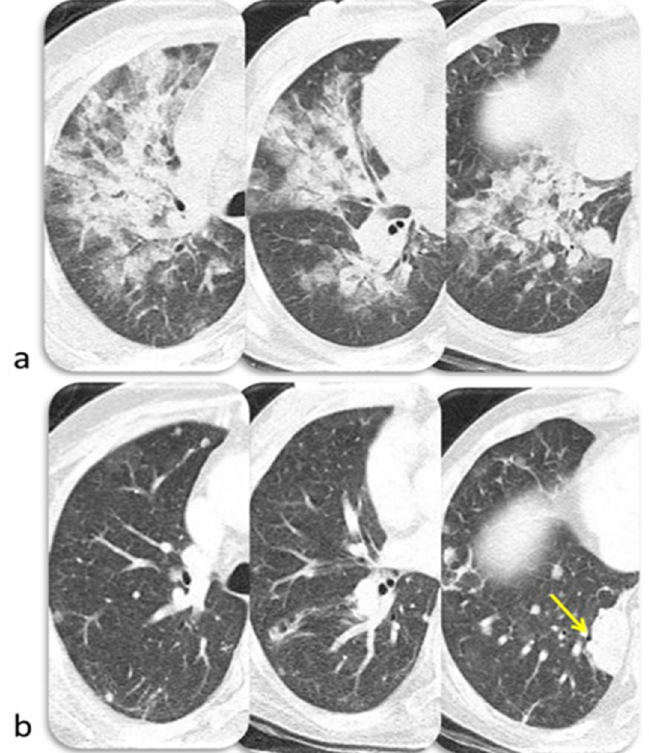
Figure 5. Immune related pneumonitis (pattern AIP / ARDS) in a 47-year-old woman with metastatic thymic carcinoma during treatment with pembrolizumab ( a ). CT image after 2 months of steroid therapy shows resolution of ARDS ( b ) and progressive disease (yellow arrow). © Department of Radiology, University of Pisa.